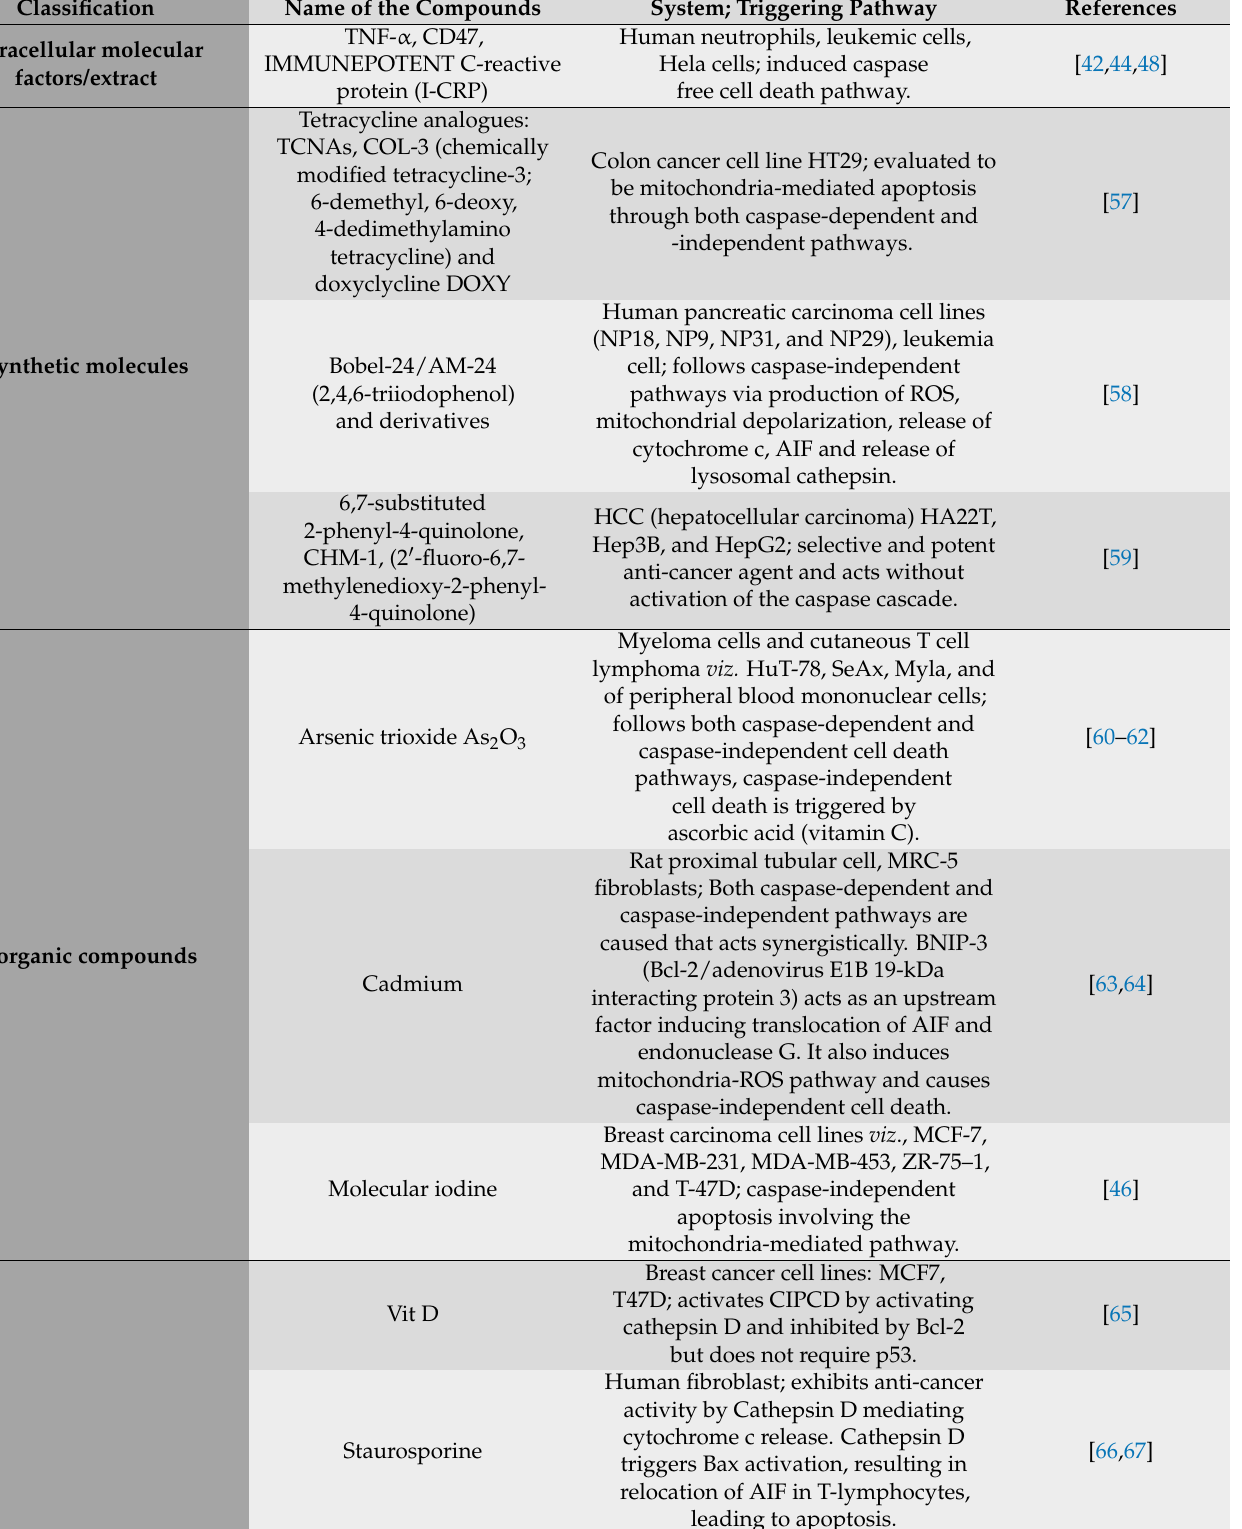
Table 1. Overview of inducing agents engaged in caspase-independent programmed cell